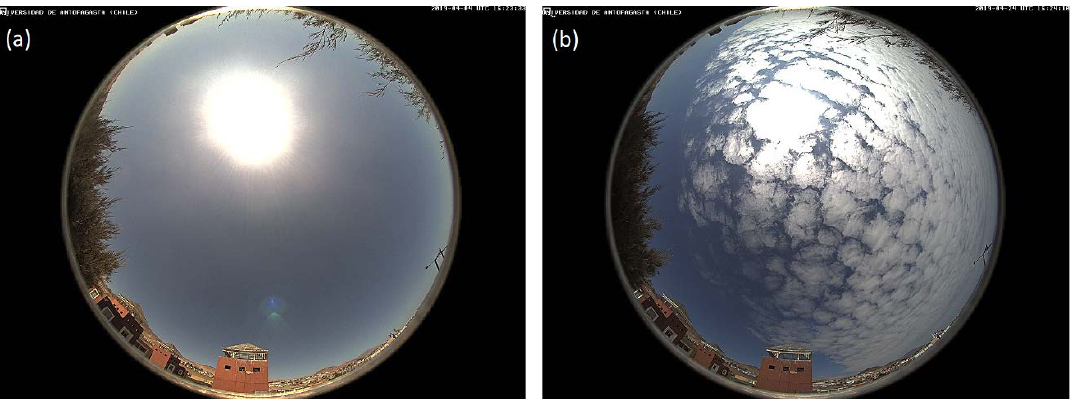
Figure 11. Images from the sky camera at Universidad de Antofagasta, showing a clear day ( a ) and an overcast day ( b ).